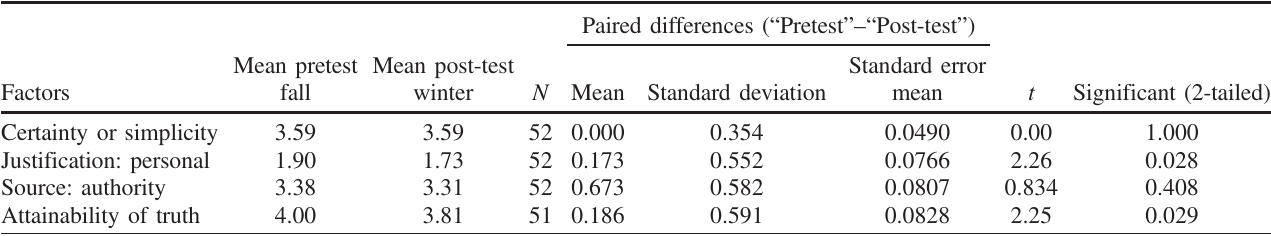
TABLE IX. The results of paired t test for the control group at the end of the winter semester 2015 (post-test) compared to the beginning of the fall semester 2014 (pretest).